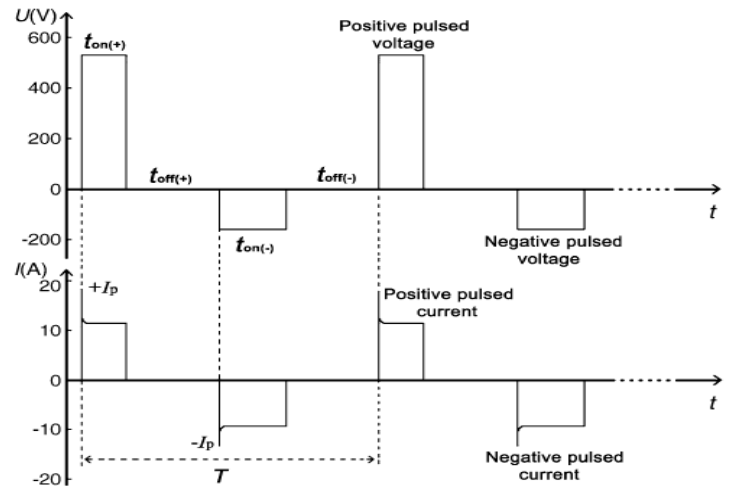
Figure 1. The schematic drawing of the current-voltage waveform in the process of power supply operation.